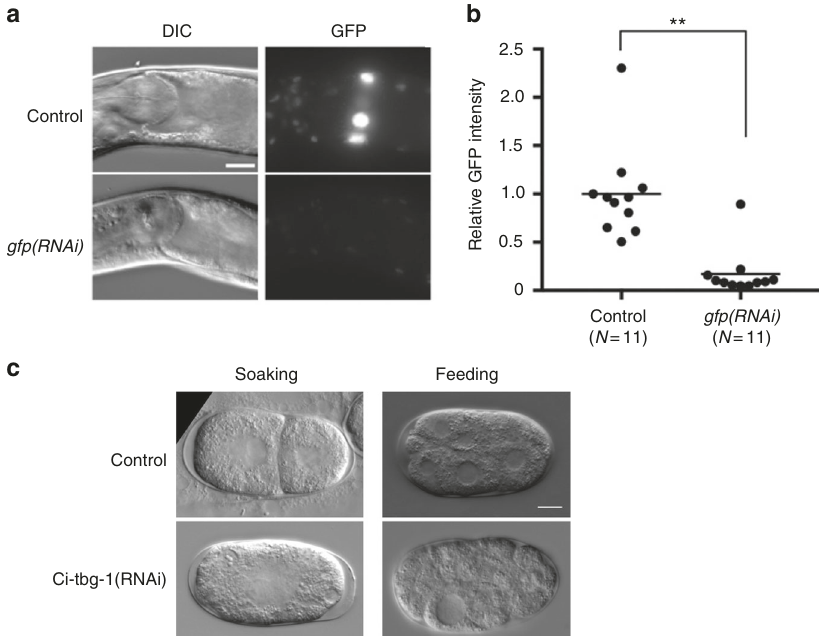
Fig. 6 RNAi ef fi ciency in C. inopinata . a Feeding RNAi in C. inopinata . The GFP encoding transgene in a transgenic line from Fig. 3a was targeted by feeding RNAi. The GFP signal was signi fi cantly reduced. Scale bar: 20 μ m. b Ef fi ciency of gfp(RNAi) . Relative intensities of the GFP signal in control and RNAi- treated worms was compared. ** p < 0.01, Student's t -test. c Soaking and feeding RNAi of Ci-tbg-1 . Embryos were arrested with cell division defects (soaking RNAi: 1-cell arrest, feeding RNAi: early embryo with some abnormally large nuclei). Scale bar: 10 μ